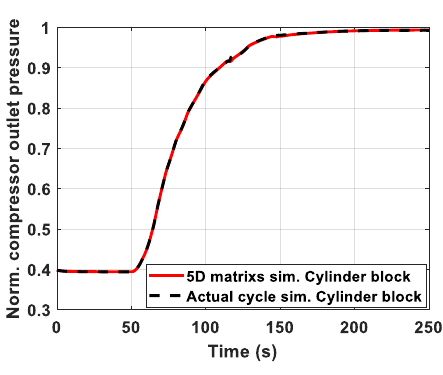
Figure 10. Compressor outlet pressure time history .